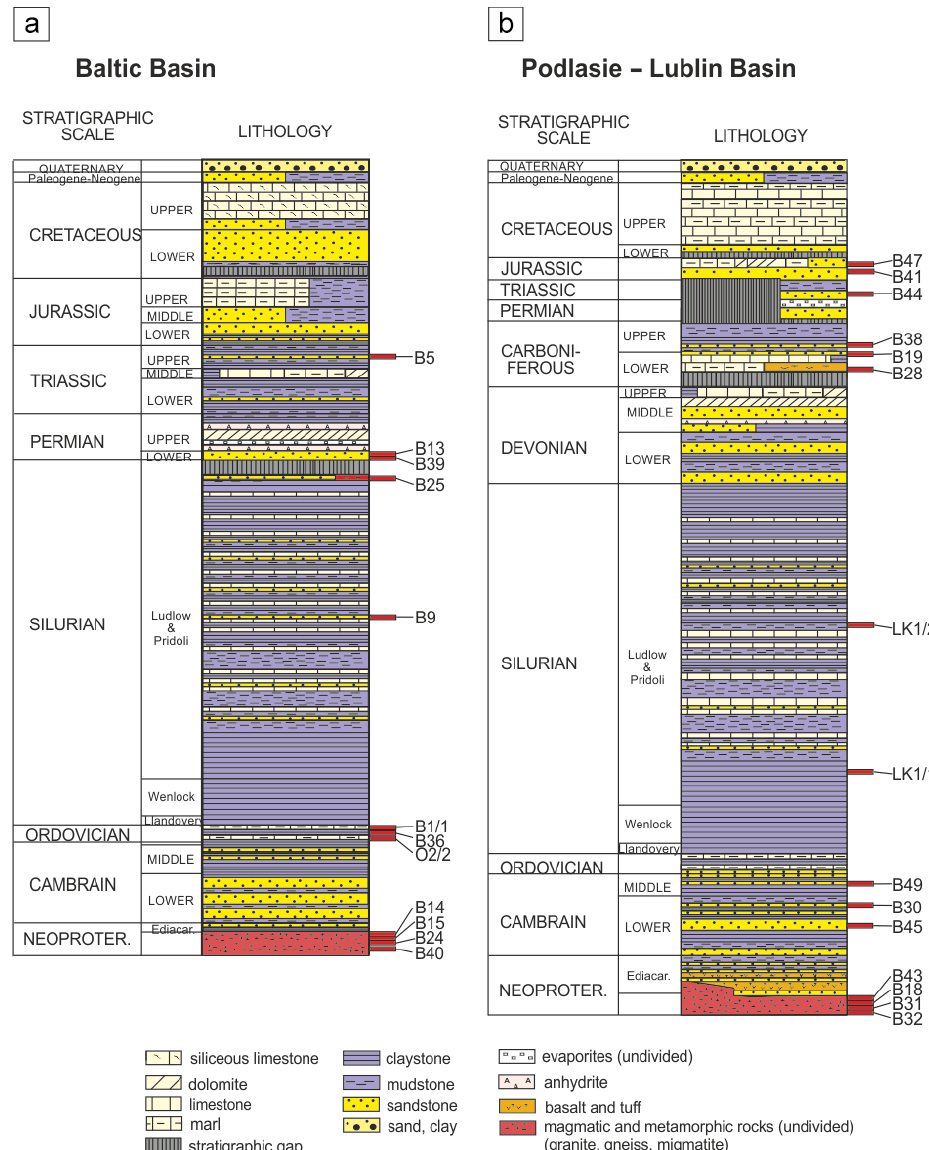
Figure 3. Simplified chronostratigraphic logs for the (a) Baltic Basin and (b) Podlasie–Lublin basins the location of samples indicated (based on various sources including ˙Zelichowski, 1987; Modli ´ nski et al., 2010; Poprawa,